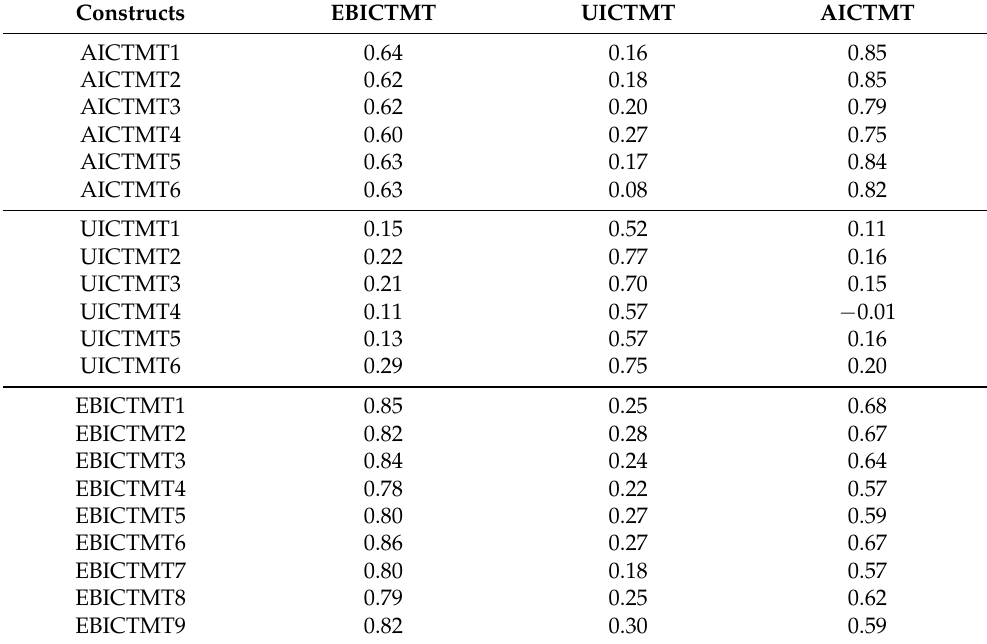
Table 2. Discriminant validity-cross